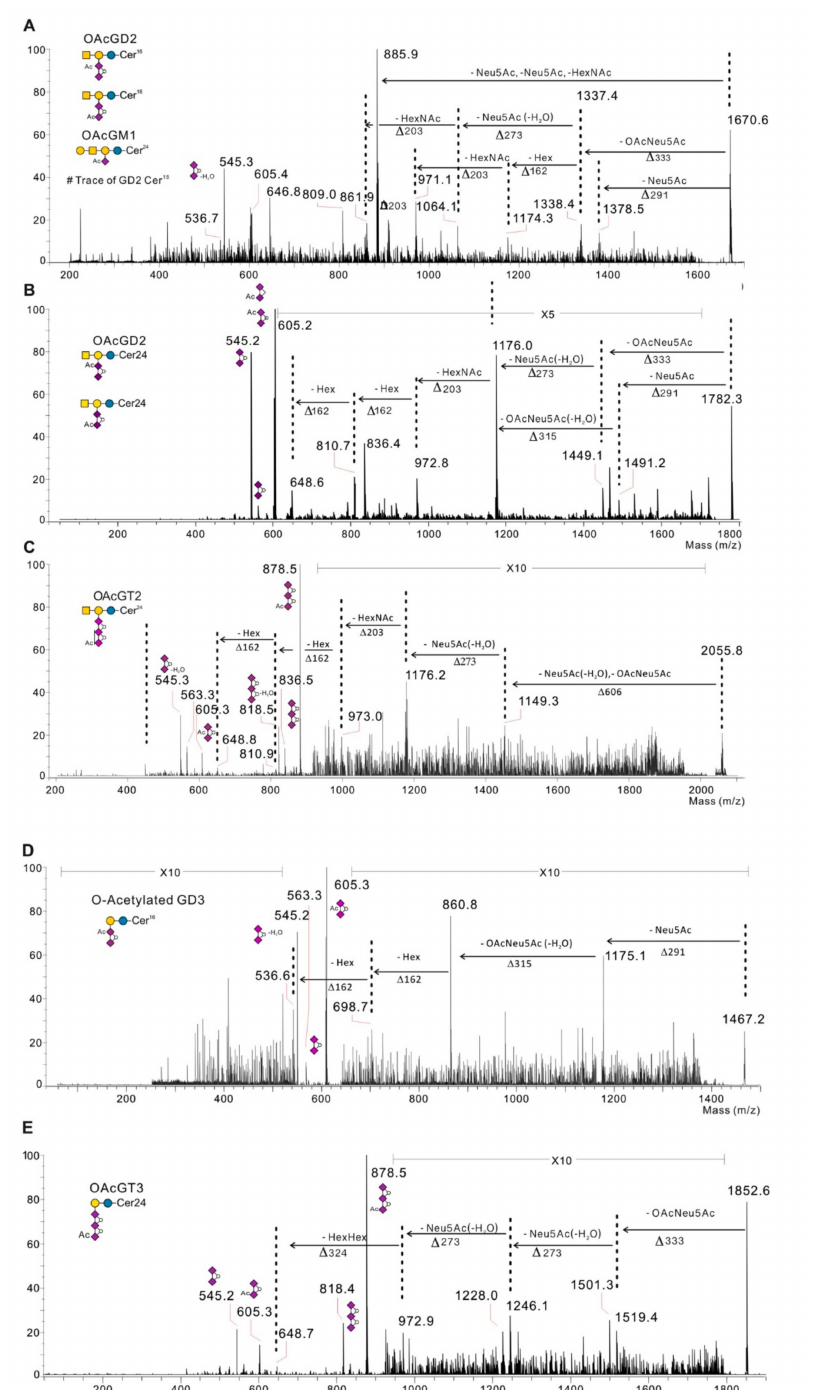
Figure 4. Representative MS / MS fragmentation of the molecular ion corresponding to O AcGM1, O AcGD3, O AcGD2, O AcGT3, and O AcGT2. ( A ) MS / MS fragmentation of the molecular ion m / z 1670 in Hs 578T corresponding to O AcGM1 and O AcGD2 ganglioside. MS / MS fragmentation of the molecular ion m / z 1782 ( B ) m / z 2055 ( C ) respectively corresponding to O AcGD2 and O AcGT2 gangliosides in MDA-MB-231 GD3S + clone #4. ( D ) MS / MS fragmentation of the molecular ion m / z 1467 corresponding to O AcGD3 identified in SK-Mel-28. ( E ) MS / MS fragmentation of the molecular ion m / z 1852 corresponding to O AcGT3 identified in MDA-MB-231 GD3S + clone #11. Gangliosides are indicated according to the following Ceramide; Galactose; Glucose; N -acetyl-galactosamine; N -acetyl-neuraminic acid, ◦ dehydration Ac: O -acetyl